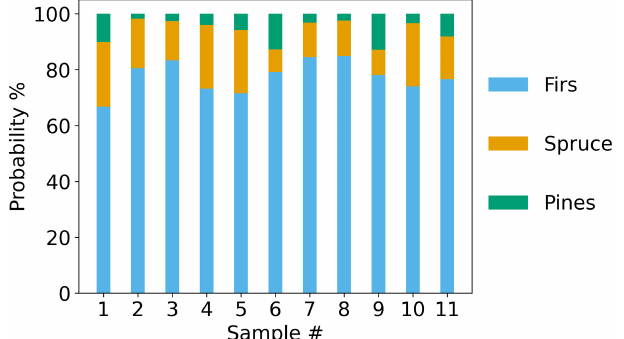
Figure 16. Classification probability by fuel class for plot